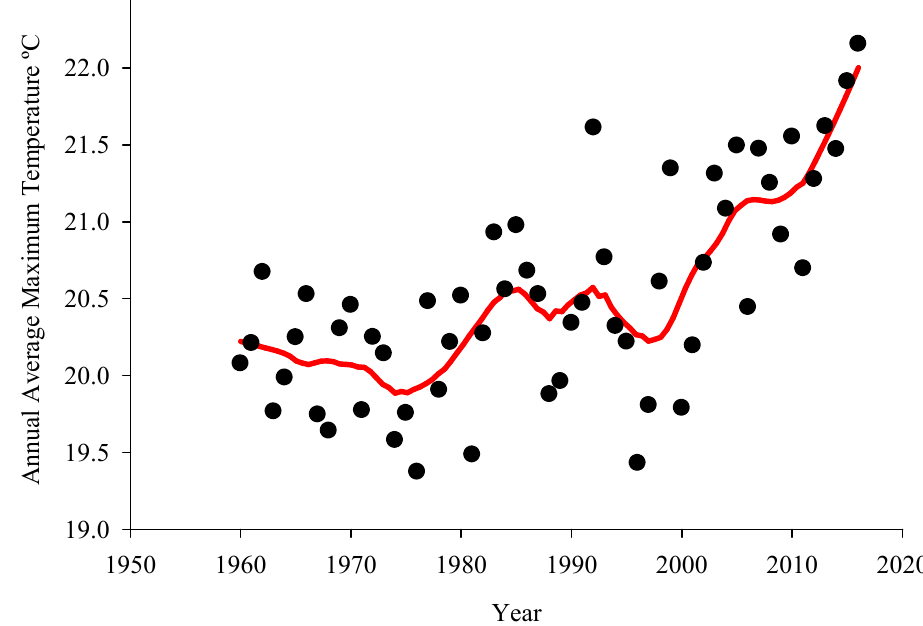
Figure 4. Lowess regression line for the annual average maximum temperature of Maloti-Drakensberg for the period 1960–2016.